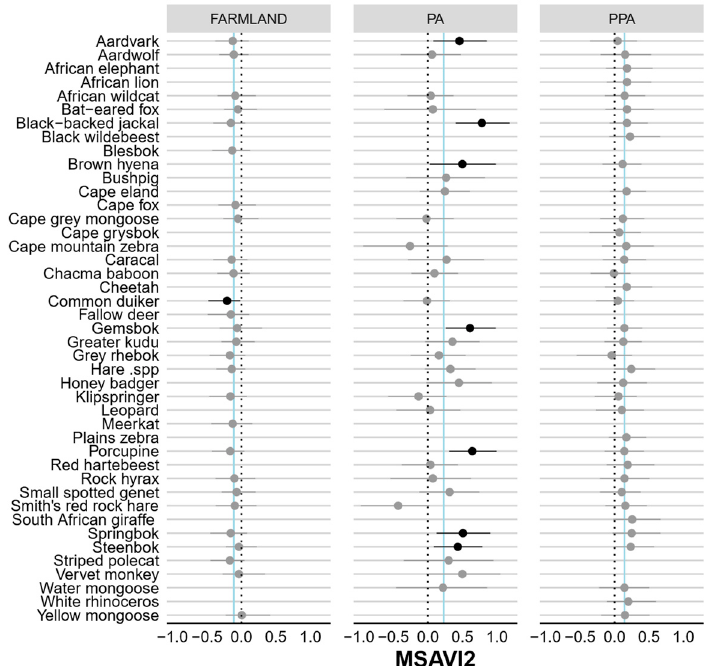
Figure A5. Caterpillar plots showing the standardised beta coefficients and 95% Bayesian credible intervals for the influence of Modified Soil-Adjusted Vegetation Index (MSAVI2) on the occurrence probability ( Ψ ) of each species in the farmland, PA and PPA. Confidence intervals in bold do not overlap 0 (dashed line), indicating significant predictors of detection. Vertical blue lines indicate community means.